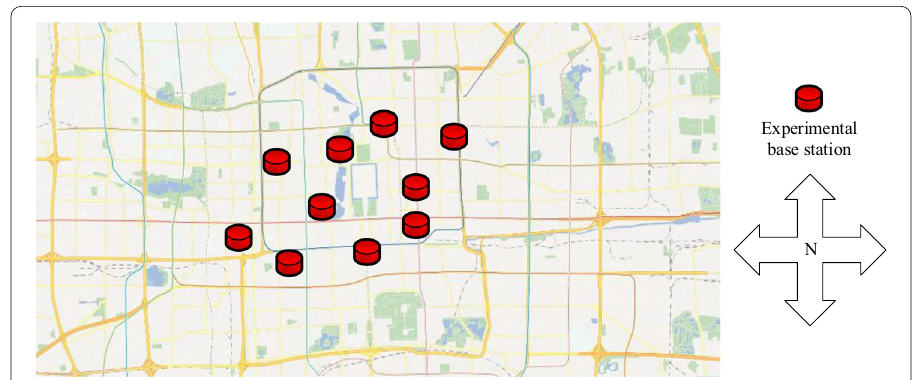
Fig. 2 Overlay of experimental base station and DEM